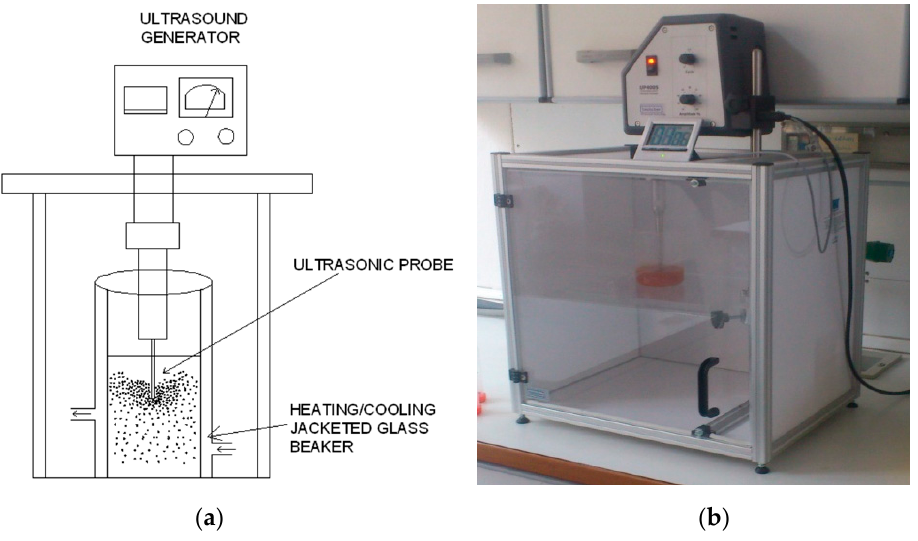
Figure 3. ( a ) Hardware of a typical ultrasound extractor and ( b ) ultrasound-assisted